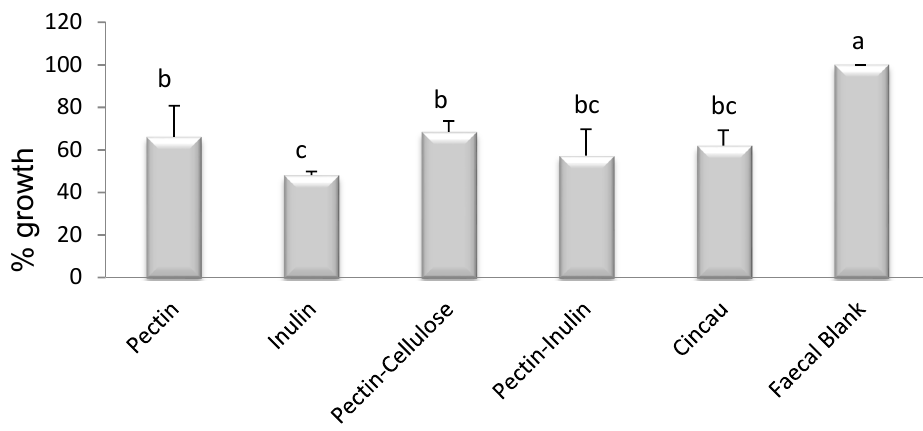
Figure 2. All dietary fibre sources reduced Caco-2 cell viability. Cells were seeded 1 day before the treatment with (fermentation supernatant) FS (day 0), then incubated for 48 h in media containing 20% FS. The bars represent the mean, and the lines are SEM of three independent experiments each performed in triplicate. Data points denoted by different superscripts (letters above the bar) differ significantly with p < 0.05.